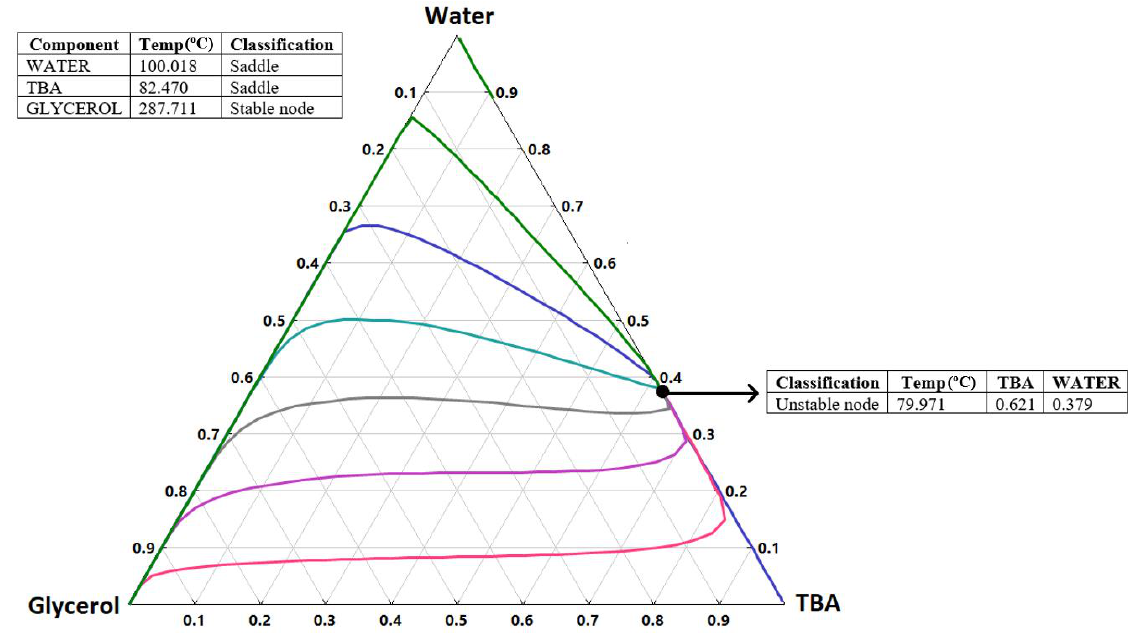
Figure 12. Residue curves map of the TBA-water-glycerol mixture at a pressure of 1 bar.